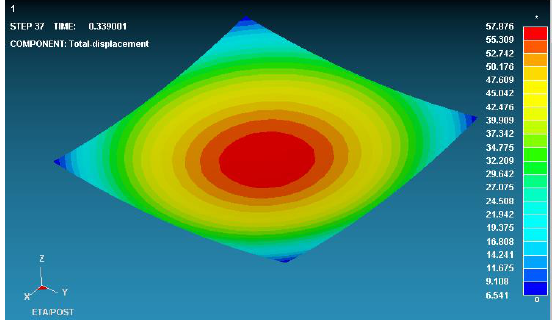
Figure 5. Contour diagram of deformation displacement of the spherical part.